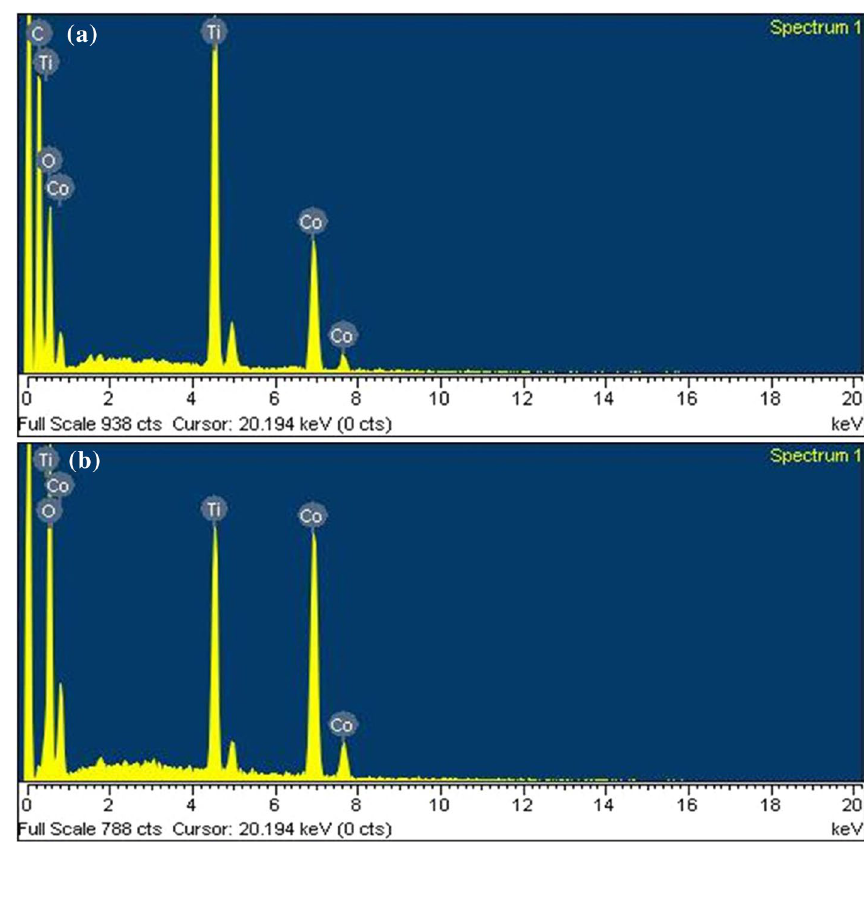
Fig. 3 EDX spectra of a F-MWCNTs/Co–Ti oxides and